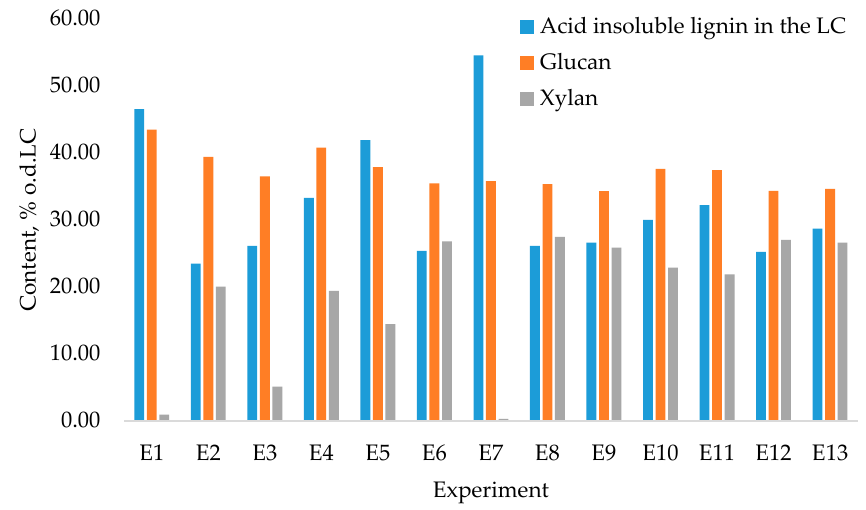
Figure 9. LC yield (% o.d.m.) from raw material.